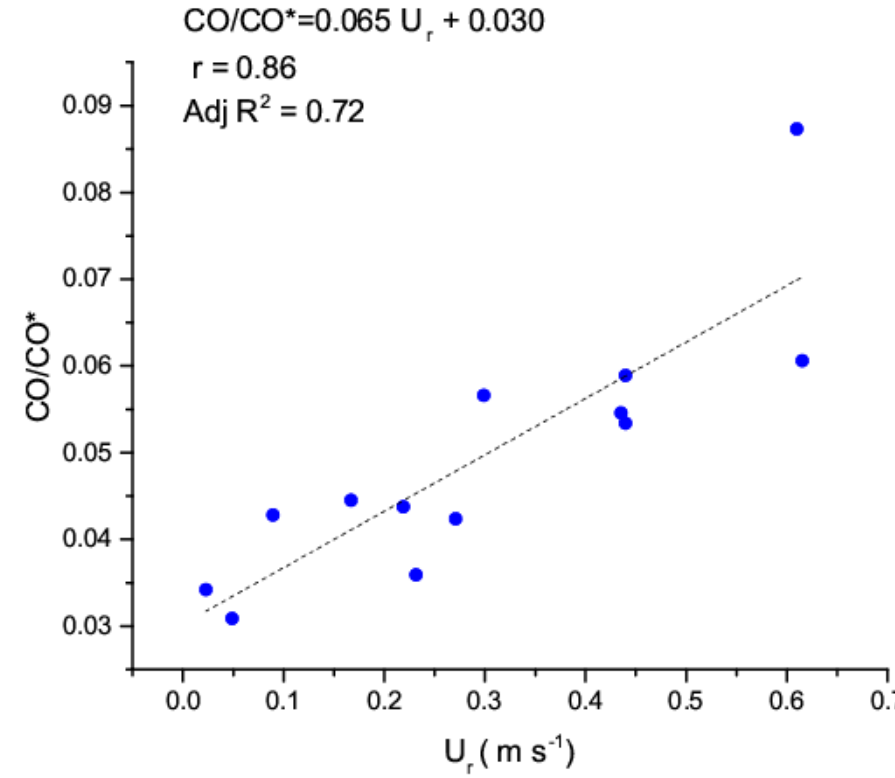
Figure 10. Scatterplot of normalized concentrations vs. thermal circulation velocity in Marconi St. during the summer intensive thermographic campaign.